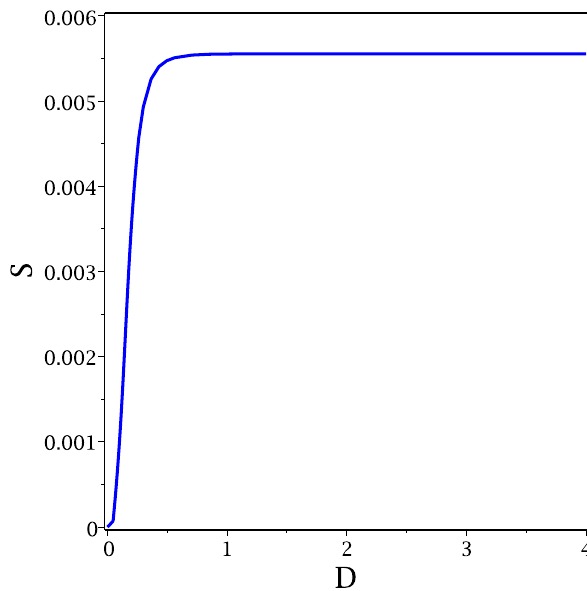
Fig. 9 The entropy S vs radius D . We have chosen σ 0 = 4, δ = 0 . 01, A 0 = 1, (cid:8)(ε) = − 1, m = 1 and H (ε) = 1 .